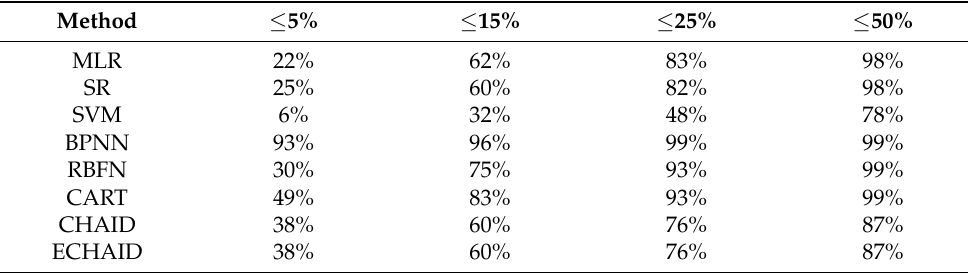
Table 5. Range of relative errors for the eight natural gas consumption prediction